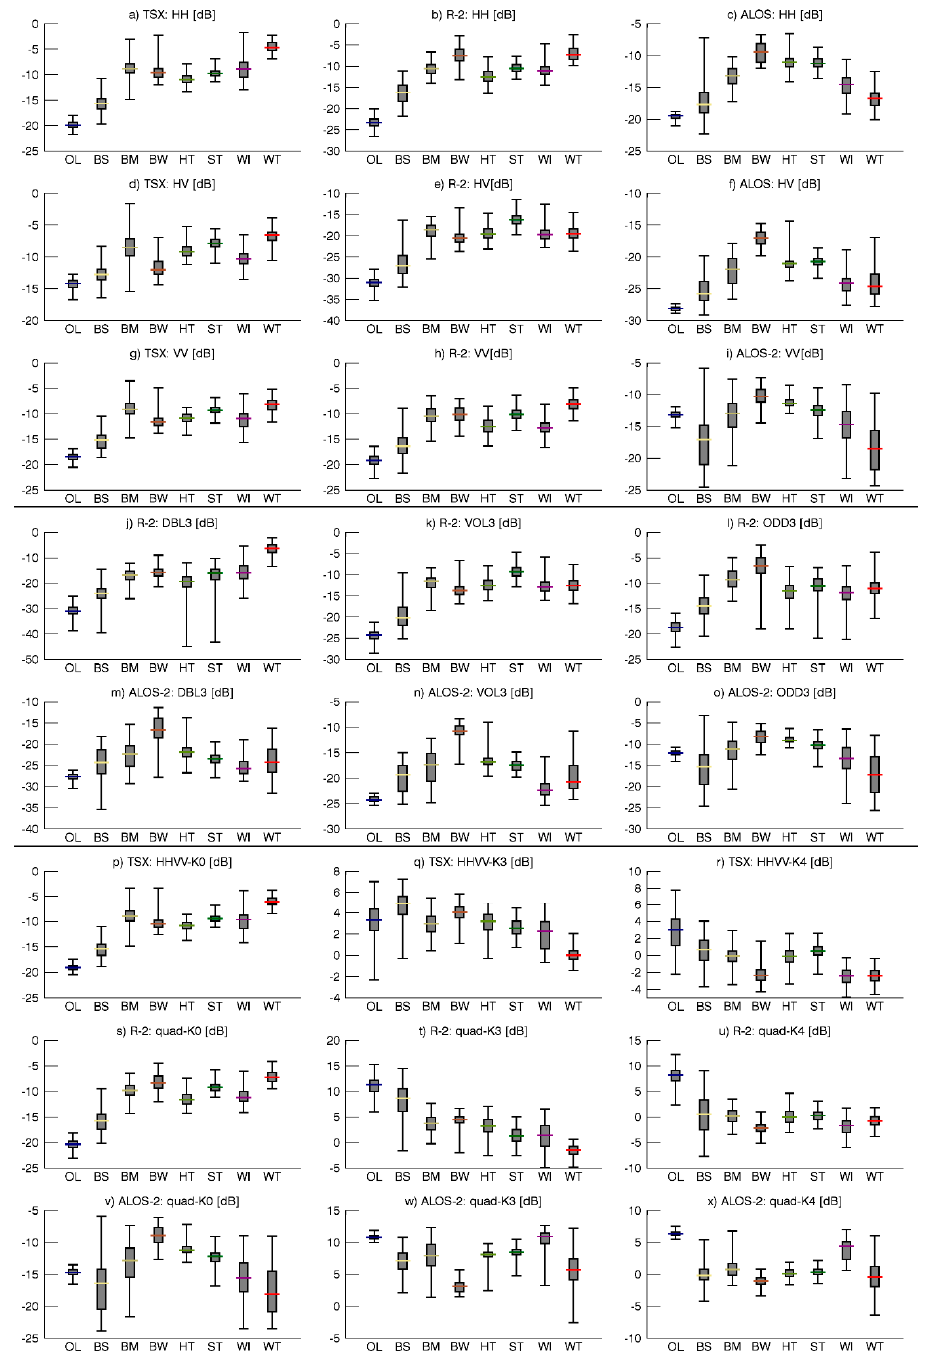
Figure 5. Boxplots (minimum, lower quartile (25%), median (50%), upper quartile (75%), maximum) of ( a – i ) the polarimetric channels (HH/HV/VV) of TSX, R-2, ALOS and ALOS-2; ( j – o ) Yamaguchi Decomposition features (DBL3/VOL3/ODD3) of R-2 and ALOS-2; ( p – x ) Kennaugh Matrix elements (K0/K3/K4) of TSX, R-2 and ALOS-2 for the land cover classes OL (Permanent Water Bodies), BS (Sand), BM (Mixed Sediment), BW (Driftwood Accumulation), HT (Herb Dominated Tundra), ST (Shrub Dominated Tundra), WI (Inundated Low Lying Tundra) and WT (Wetland) (see Table 2).